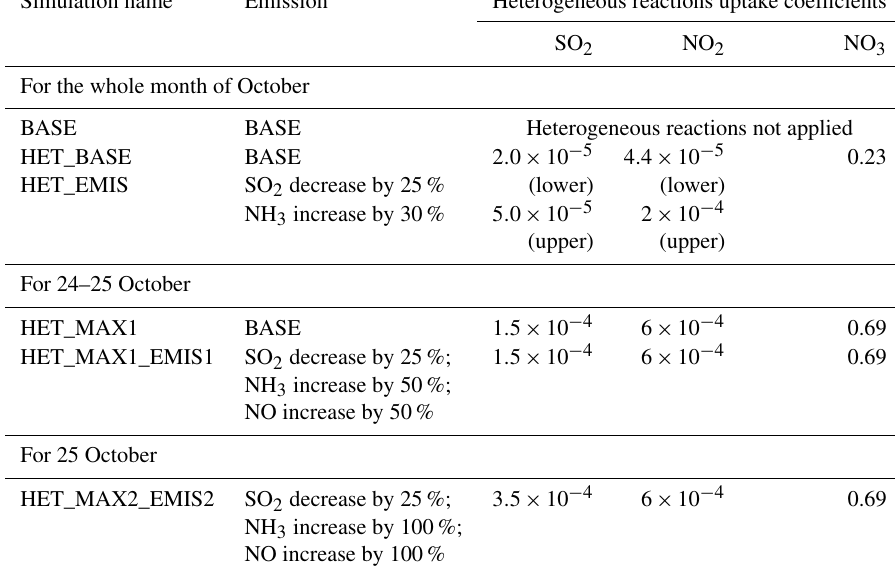
Table 3. Simulation